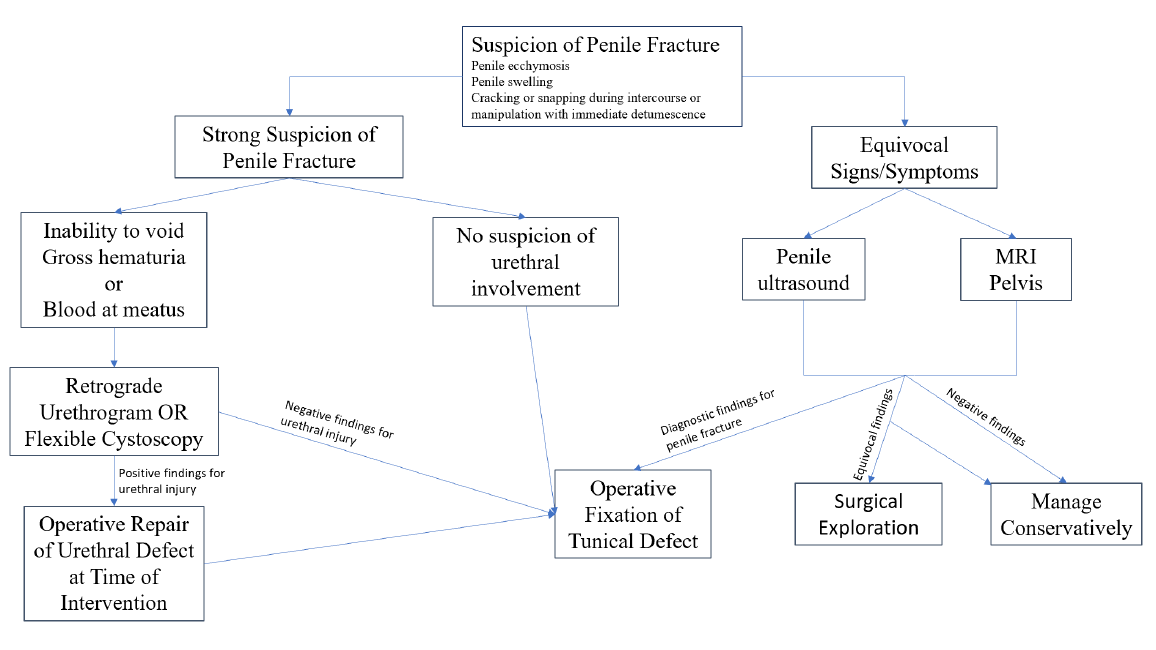
Fig. 4. Penile fracture diagnostic and therapeutic